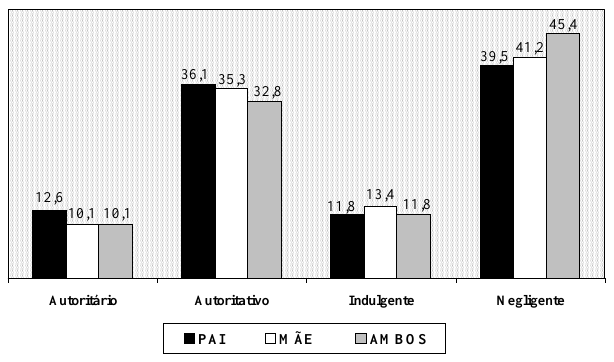
Figura 1. Percentual dos estilos dos pais, das mªes e dos dois combinados, considerando apenas os dados obtidos por meio das